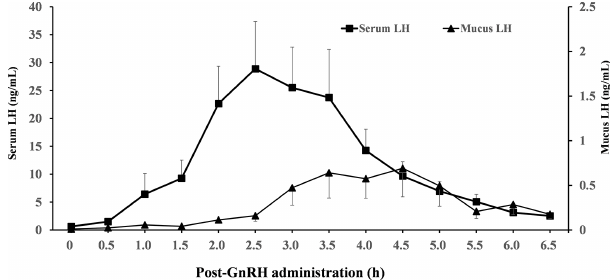
Figure 1. Mean ( ± standard error of the mean) concentrations of luteinizing hormone (LH) in serum and vaginal mucus from the start of gonadotropin-releasing hormone (GnRH) injection to 6.5h. All cows received a PRID-Delta for 9d, which was removed at the time of cloprostenol treatment. A total of 2d after the cloprostenol treatment, cows received GnRH. Samples were collected immedi- ately before GnRH administration and every 30min up to 6.5h after GnRH treatment. The peak LH concentration was observed at 2.5 and 4.5h after GnRH injection in serum and vaginal mucus respec-